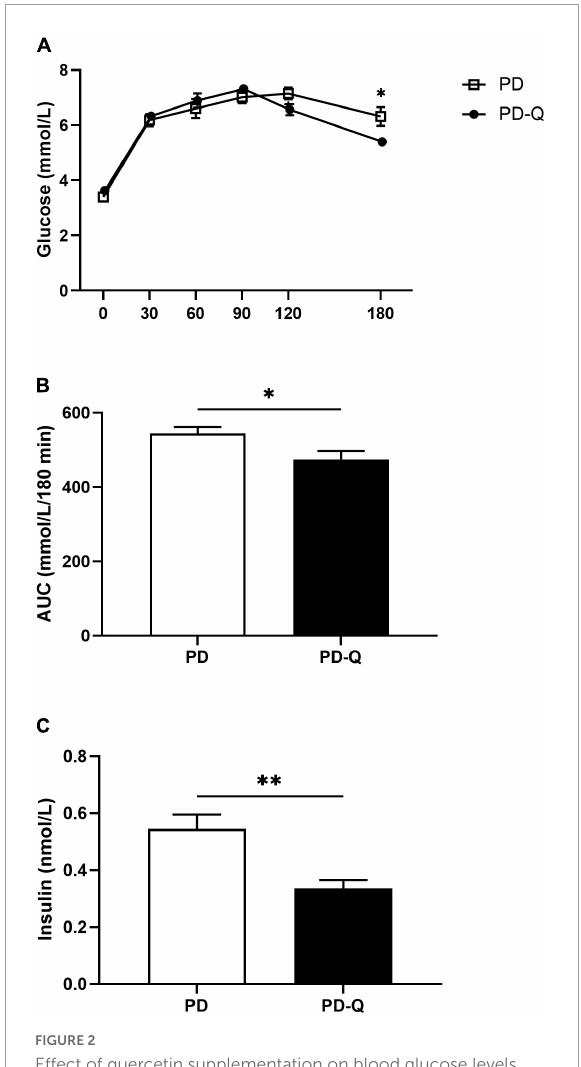
FIGURE2 Effect of quercetin supplementation on blood glucose levels during oral glucose tolerance test (A) , area under the curve [AUC, (B) ] and insulin levels (C) . Values are mean ± SEM, n = 6/group, * p < 0.05, ** p < 0.01, PD, control rats; PD-Q, rats supplemented with